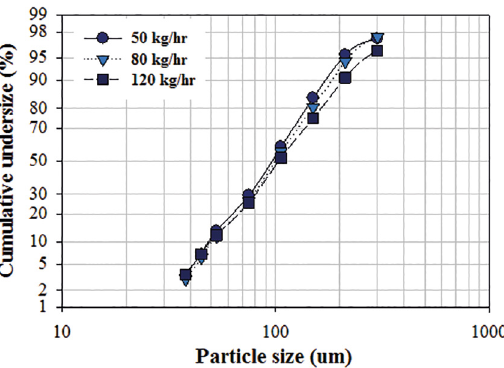
Figure 8. Effect of melt flow rate on particle size distribution. Rotating speed 30,000 rpm, 60 mm diameter disc, and 550 o C melt temperature.